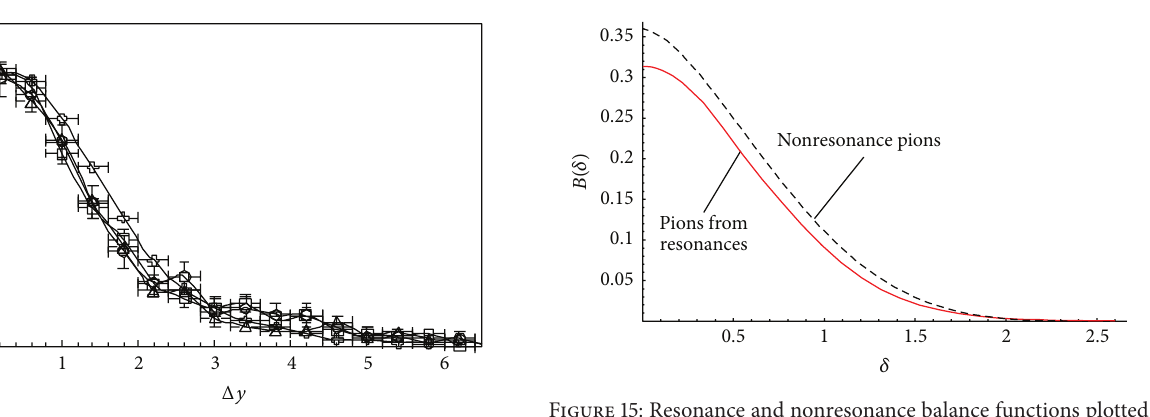
Figure 15: Resonance and nonresonance balance functions plotted as a function of the rapidity difference. 𝛿 refers to Δ𝑦 , Δ𝑦 ≡ 𝛿𝑦 . The graph is taken from